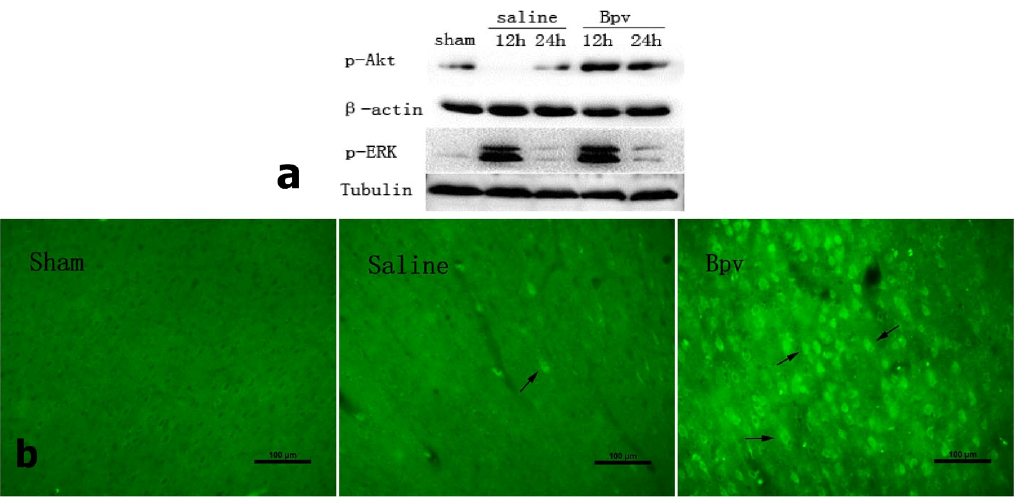
Figure 4. ( a ) Representative Western blots for p-Akt (Ser 473) and p-ERK1/2 with β -actin and tubulin serving as a loading control. n = 5; ( b ) Photomicrographs of p-Akt (Ser473) in the penumbral cortex in sham, saline-treated, and bpV-treated animals. The arrow